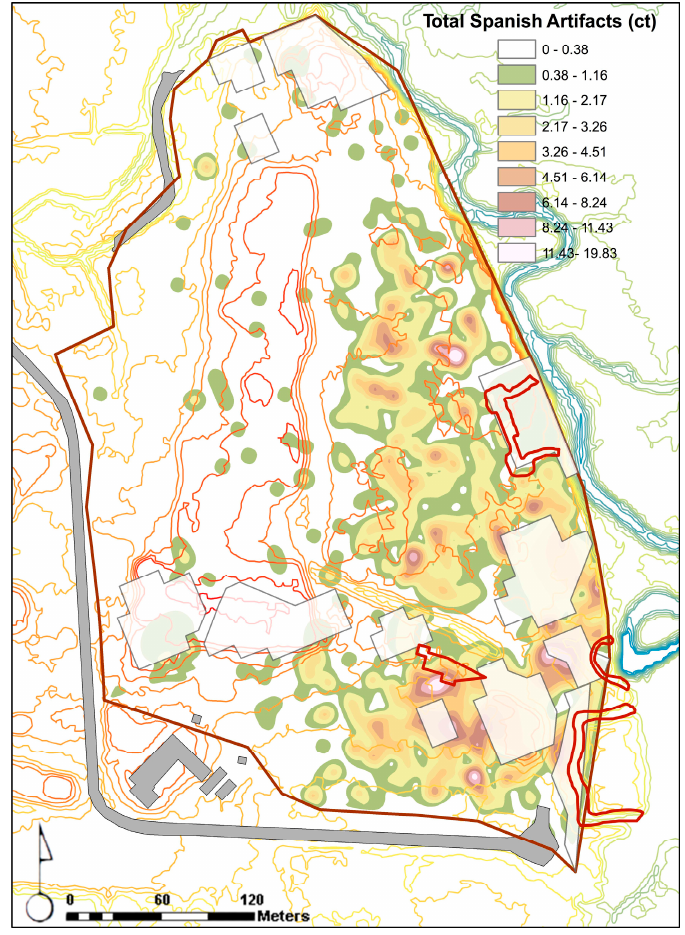
Figure 10. The distribution of all Spanish period artifacts recorded through a shovel test survey. Areas whited-out were not shovel tested. Contour spacing is 1 m. Contours are based on the LiDAR dataset and use the NAD 1983 and NAV 1988 horizontal and vertical datum, respectively.